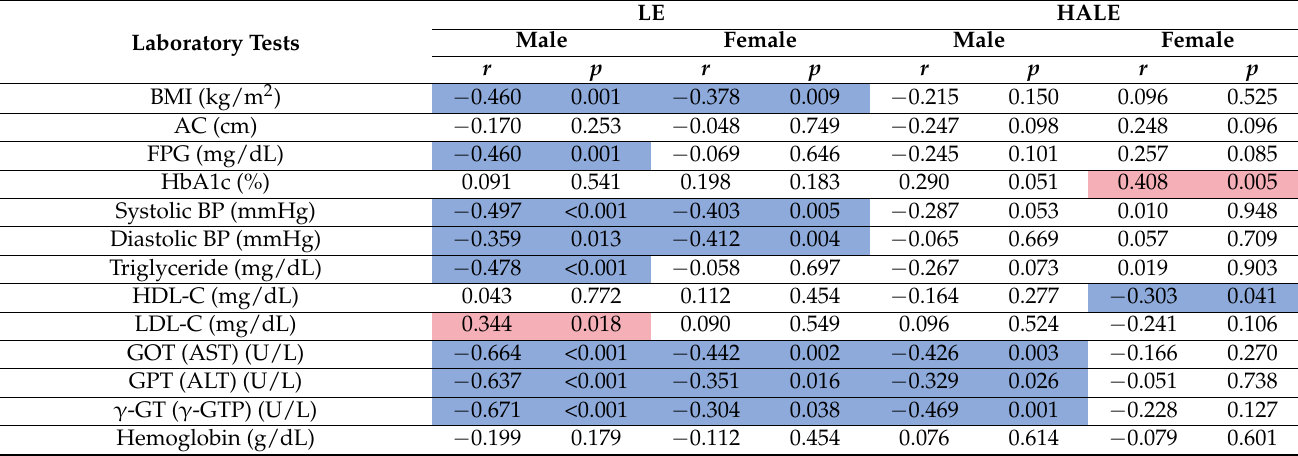
Table 4. Correlation coefficient between health check-up variables (laboratory tests) and summary population health outcomes (LE and